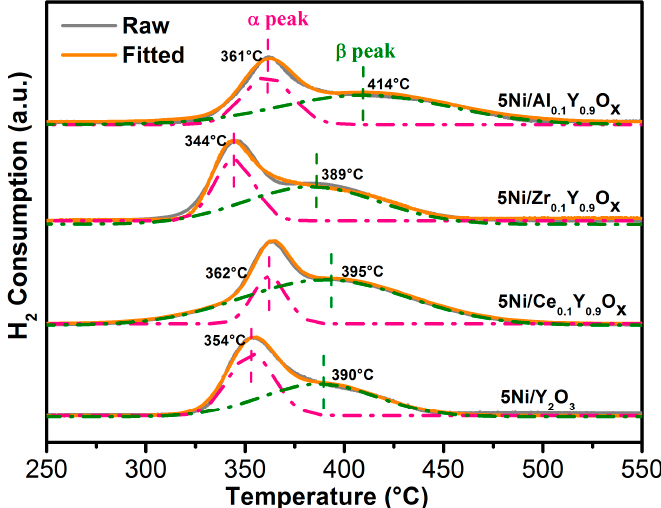
Figure 7. H 2 -TPR profiles of the fresh catalysts. Table 4. Quantified H 2 -TPR results of the fresh catalysts.